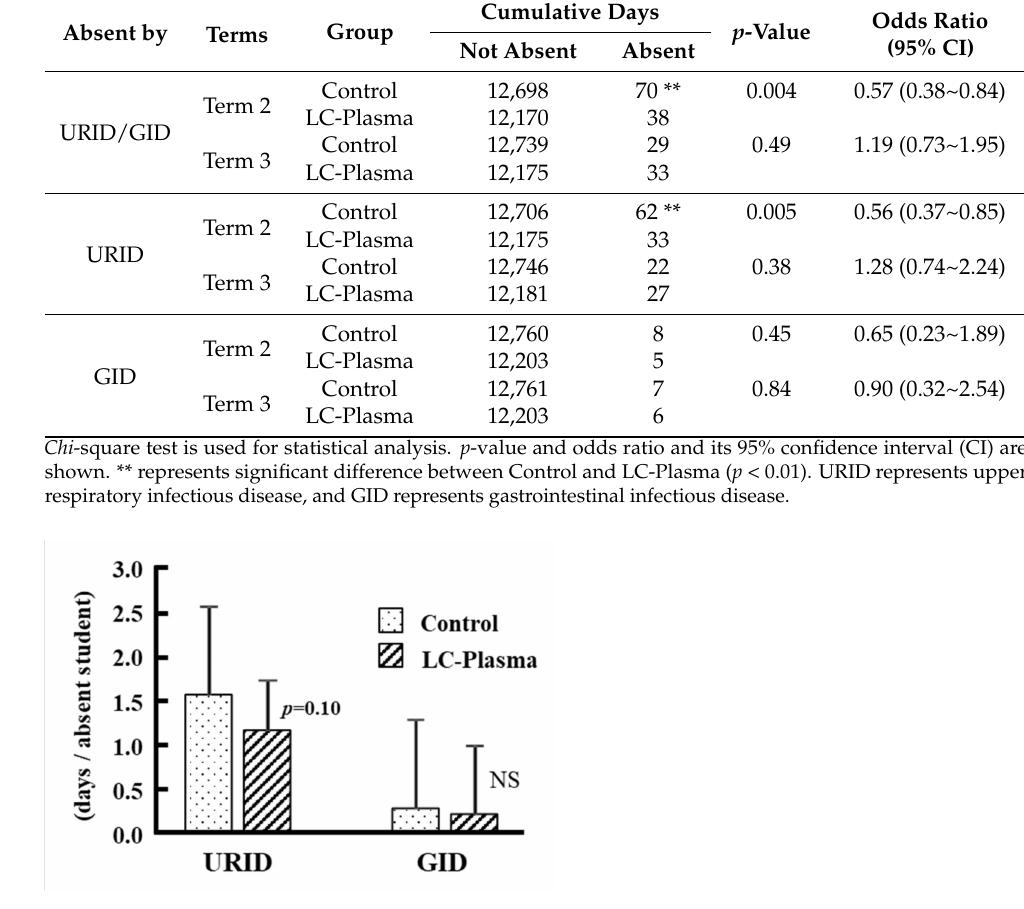
Figure 2. Number of absent days per absent student. URID represents upper respiratory infec- tious disease, and GID represents gastrointestinal infectious disease. NS; not significant difference between